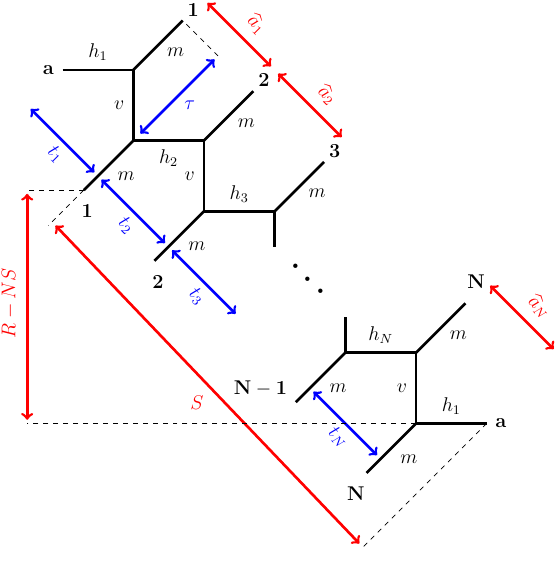
Figure 1 . Web diagram of X N; 1